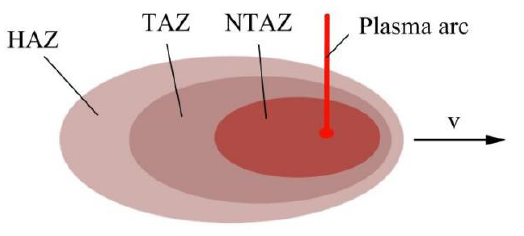
Figure 3. Non-transferred arc zone (NTAZ), transferred arc zone (TAZ), and heat affected zone (HAZ) in the molten pool.